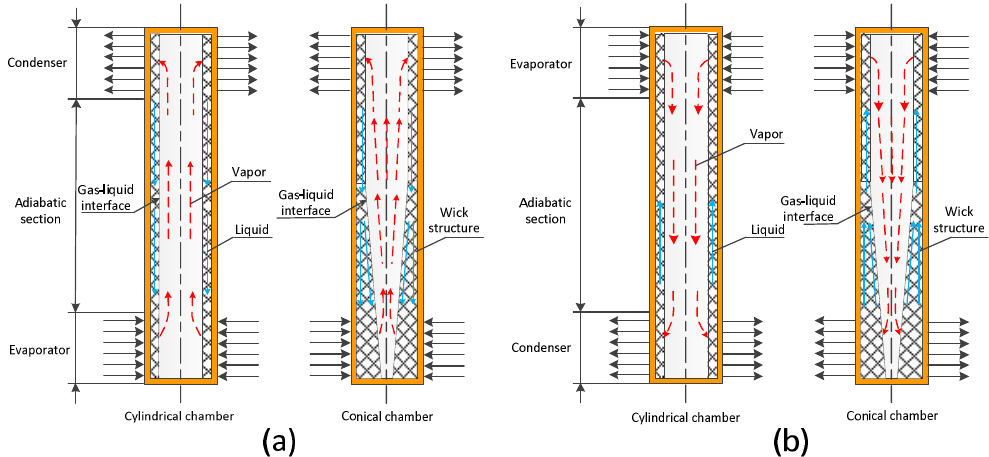
Figure 10. Mechanisms of heat pipes with conventional and conical chamber under ( a ) gravity assistance heating condition and ( b ) anti-gravity heating condition.